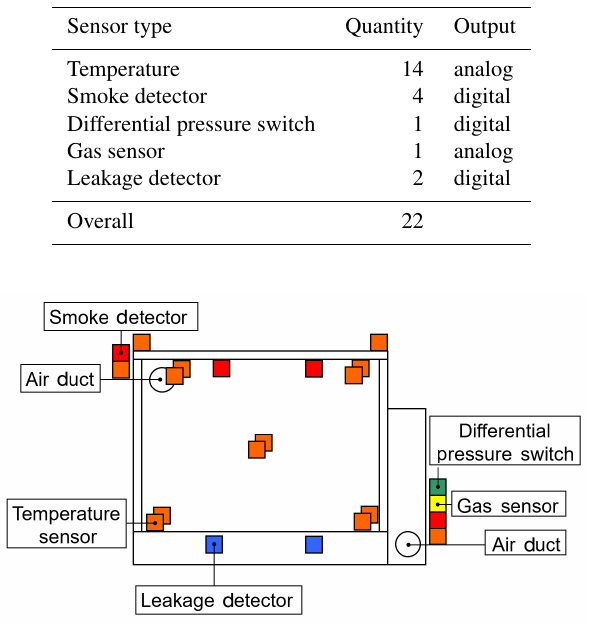
Figure 6. A schematic view of the hazardous material store with the sensors included. The different sensors are shown in different colours (temperature sensor: orange; smoke detector: red; leakage detector: blue; gas sensor: yellow; differential power switch: green). Additionally the air ducts are